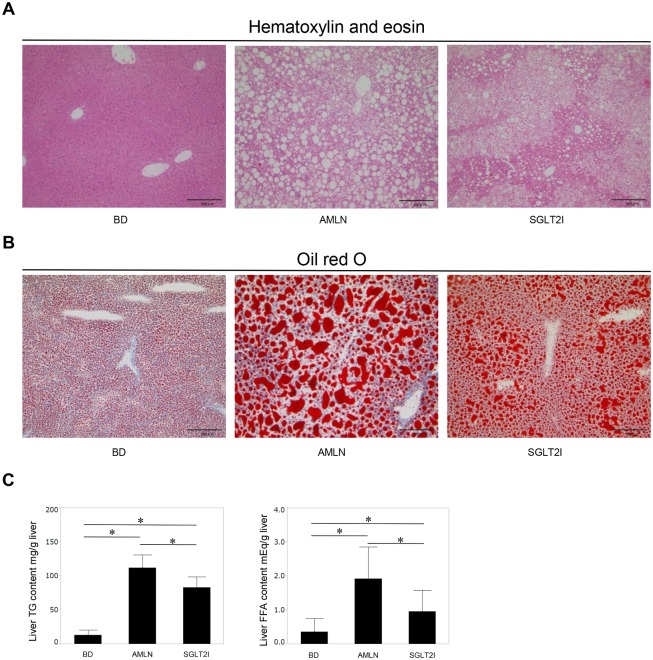
Ipragliflozin improved steatosis and decreased lipid content in the liver.(A) Liver sections from BD mice, AMLN mice and SGLT2I mice. Hematoxylin and eosin (H&E) staining, (B) oil red O staining. Magnification, 200×. Scale bars: 200 μm. (C) Triglyceride (TG) and free fatty acid (FFA) content was measured in the livers of BD, AMLN, and SGLT2I mice (n = 4–6). Results are the mean ± SD. Significance was tested using the Student’s t-test (*p<0.05).